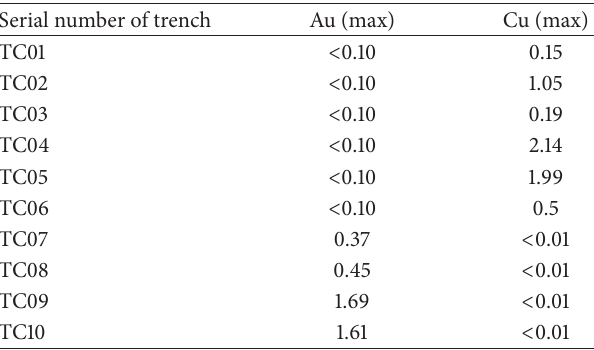
Table 5: The analysis results of chemical groove samples. Serial number of